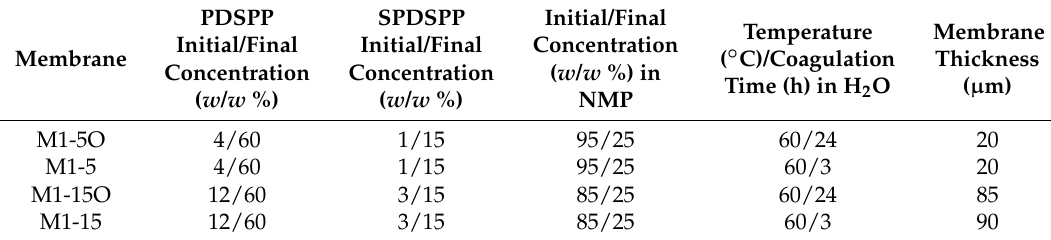
Table 2. Preparation of membranes with 80/20 w / w PDSPP/SPDSPP in NMP at 5% or 15% w / w , casting at 80 ◦ C until 75% w / w total final polymers’ concentration and immersion in H 2 O at 60 ◦ C for 3 h or 24 h.